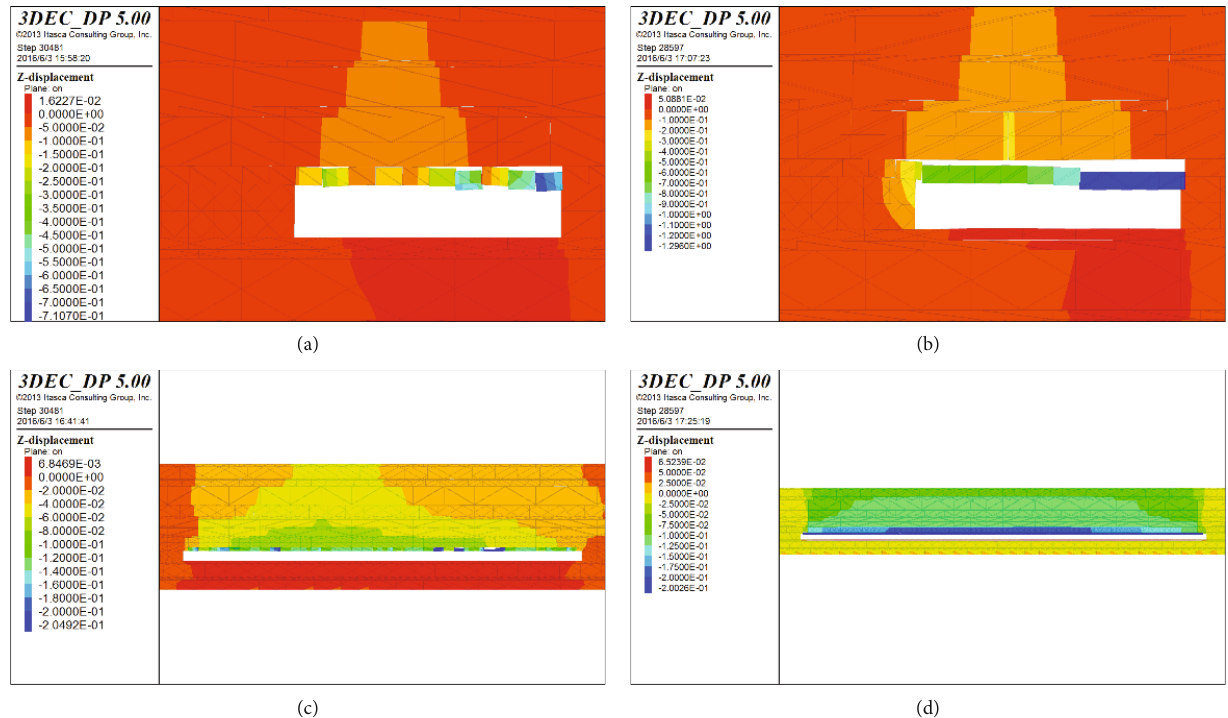
Figure 4: Nephogram of roof strata displacement when advancing to 30m (unit: m): (a) slice of the 195m working face in advancing direction, (b) slice of the 376m working face in advancing direction, (c) lengthwise slice of the 195m working face, and (d) lengthwise slice of the 376m working